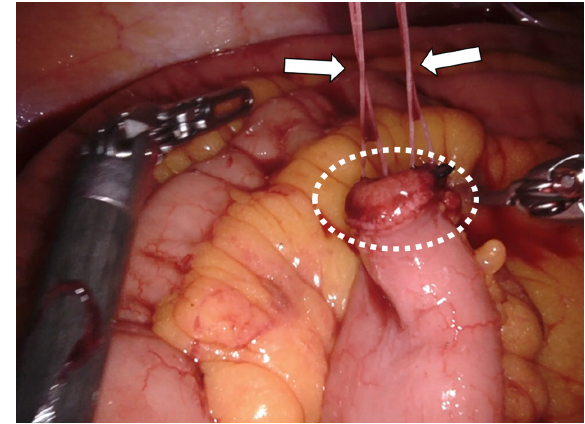
Figure 4. After uretero–uretero anastomosis, we pulled out the distal end of the ileal conduit (circle with white broken lines) by pulling the silk sutures (white arrow) tied to the intestinal mucosa of the